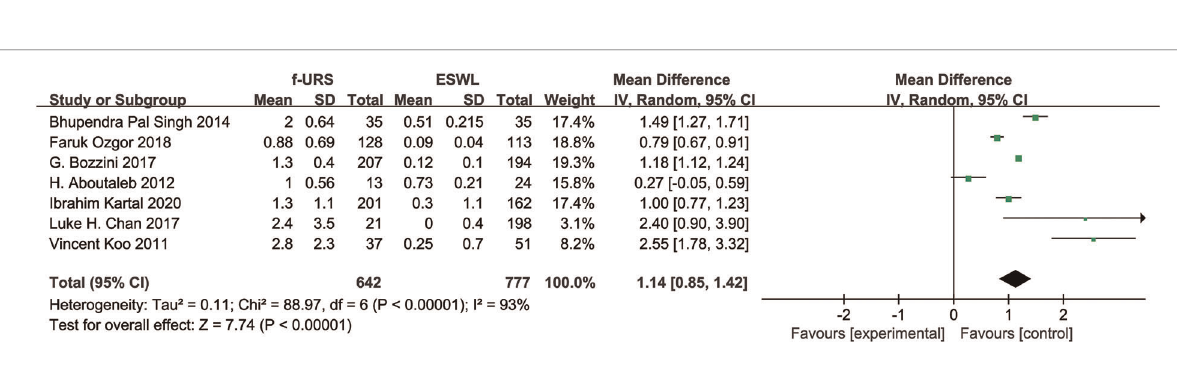
FIGURE 9 Forest plot and meta-analysis of hospital stay for f-URS and